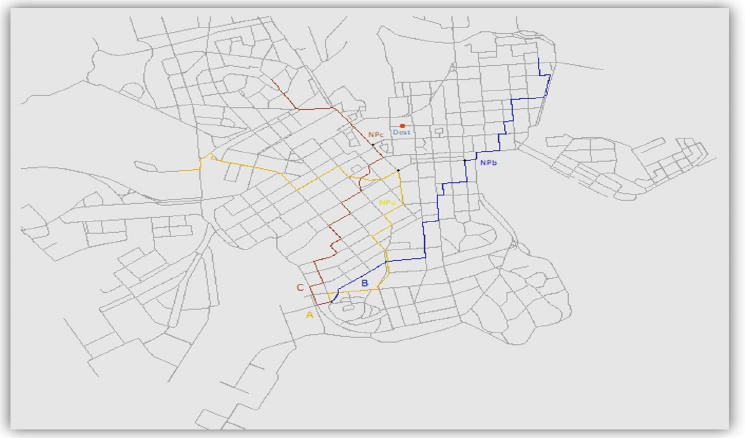
Figure 2. Restriced METD mechanism of the hybrid FA-GSO VDTN router. VDTN